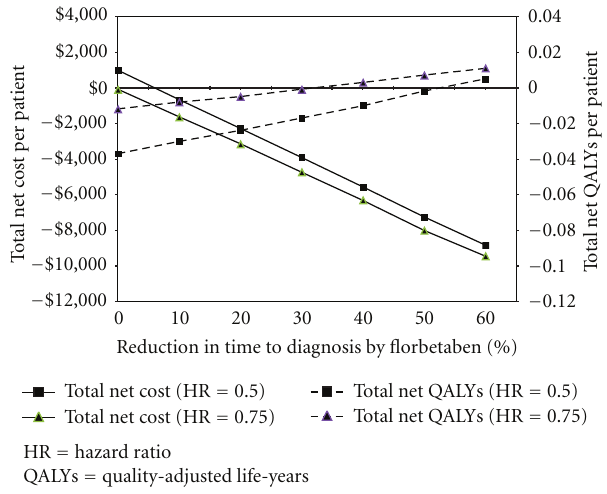
Figure 3: Impact of percent reduction in time to diagnosis on net cost and quality-adjusted